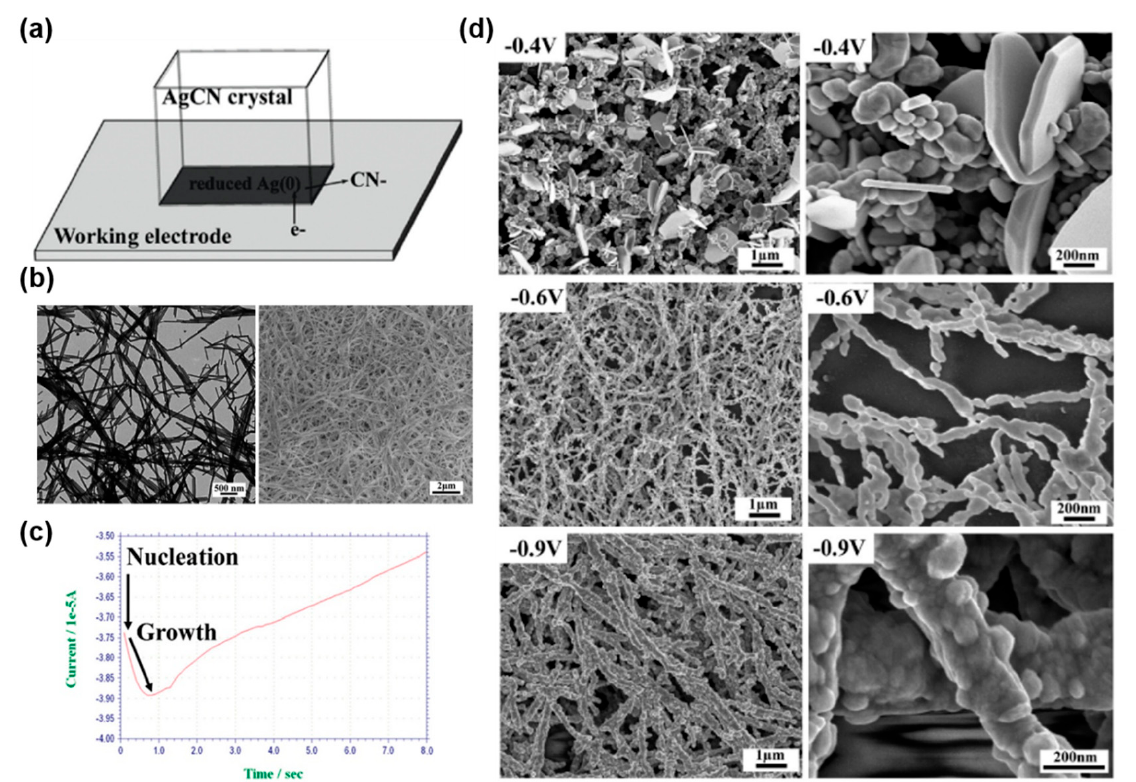
Figure 7. Electrochemical reduction of non − zero − valent metal nanostructures. ( a ) Schematic of the electrochemical reduction of solid AgCN. ( b ) TEM (left) and SEM (right) images of AgCN